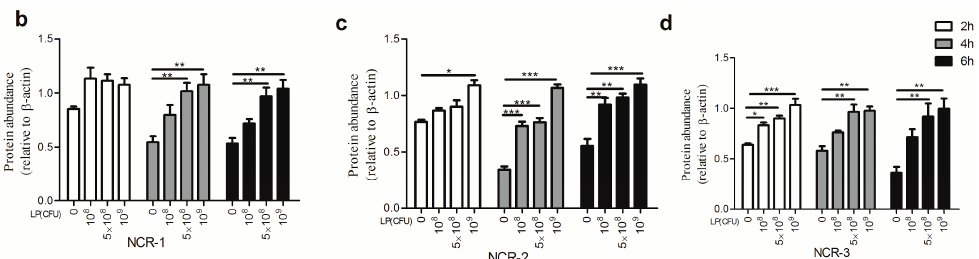
Figure 1. Lactobacillus plantarum (LP) increased the expression of natural cytotoxicity receptor (NCRs) protein levels in Natural Killer (NK) cells. NK cells were untreated or treated with L. plantarum (10 8 , 5 × 10 8 or 10 9 CFU/mL) for 2, 4 or 6 h. Cells were collected and protein abundances were analyzed. ( a ) Western blot analysis of NCR1-3 protein, equal loading was confirmed by stripping immunoblots and re-probing for β -actin; ( b – d ) are the ratios of NCR-1, NCR-2, and NCR-3 to β -actin, respectively. All data were obtained from 3 independent experiments. Data are means ± standard error of the means (SEM). * p < 0.05, ** p < 0.01, *** p < 0.001. NCR-1, natural cytotoxicity receptor 1; NCR-2, natural cytotoxicity receptor 2; NCR-3, natural cytotoxicity receptor 3.